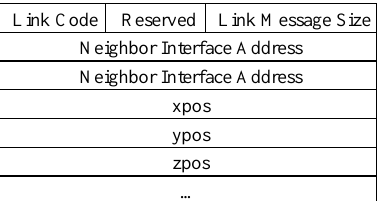
Table 2. The HELLO message format with neighbor’s location